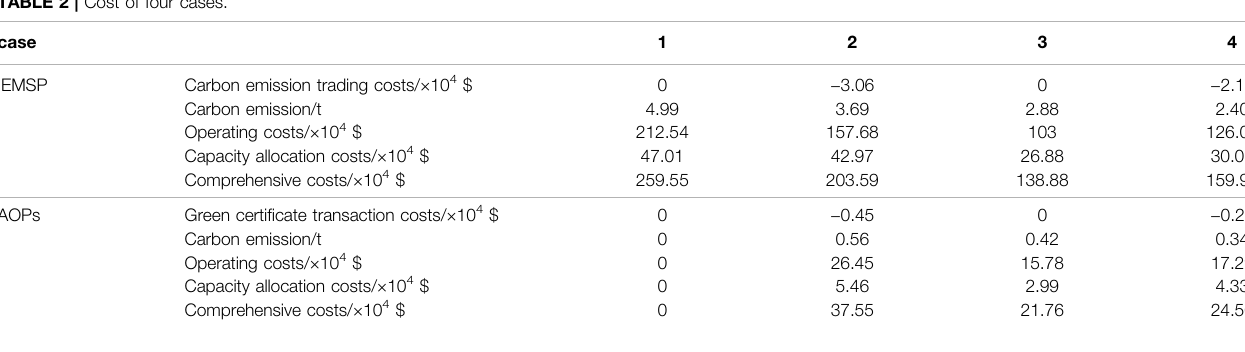
TABLE 2 | Cost of four